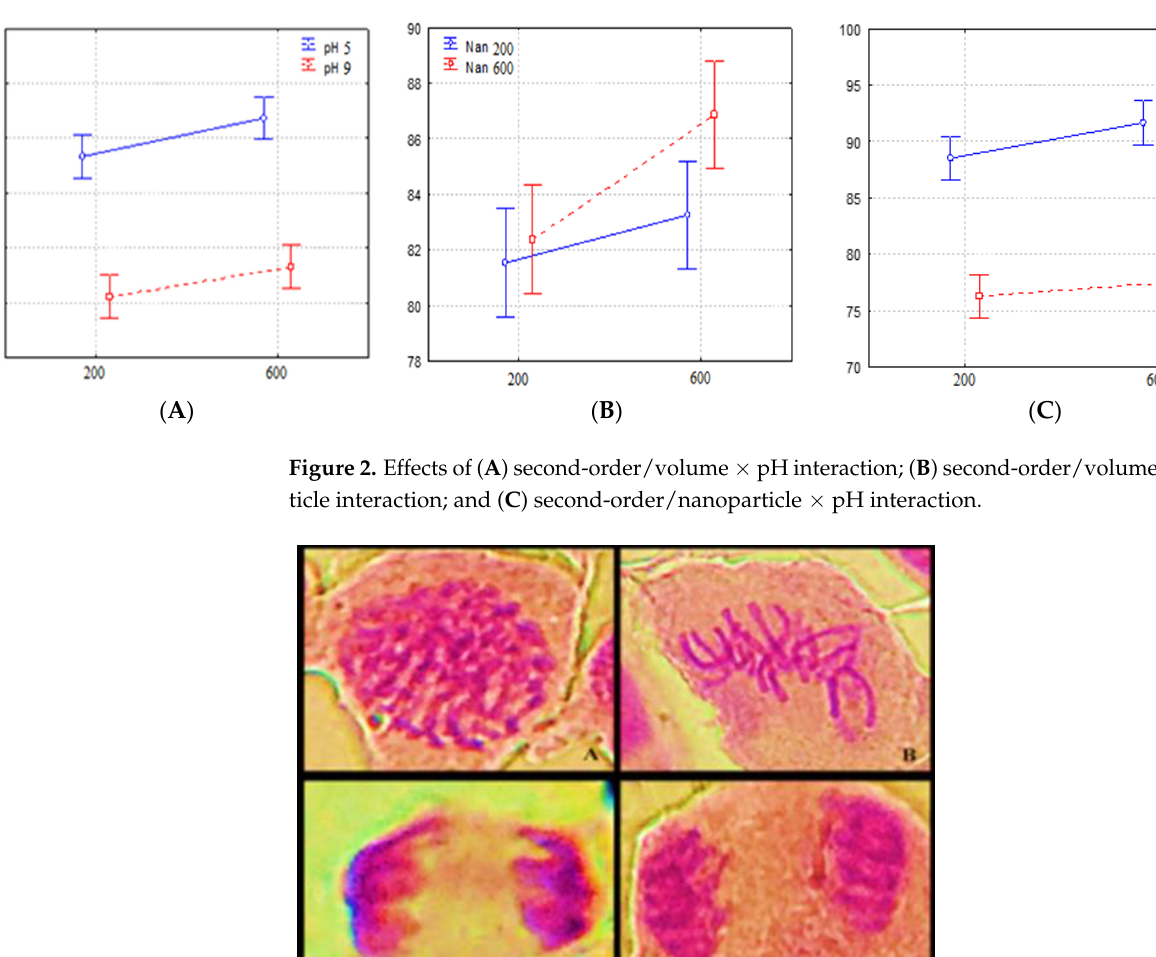
Figure 3. A light microscope photomicrograph of cell division phases: ( A ) prophase, ( B ) metaphase, ( C ) anaphase, and ( D ) telophase.